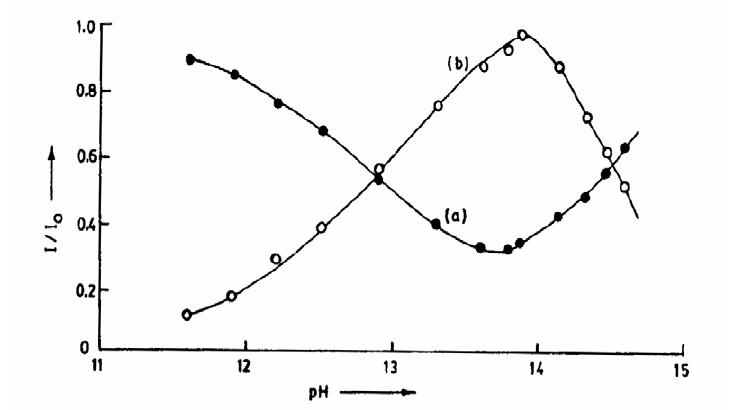
Figure 7. Plot of I/I of CAZL vs. pH of aqueous TX (5x10 -4 M) solution : (a) neutral and (b) 0